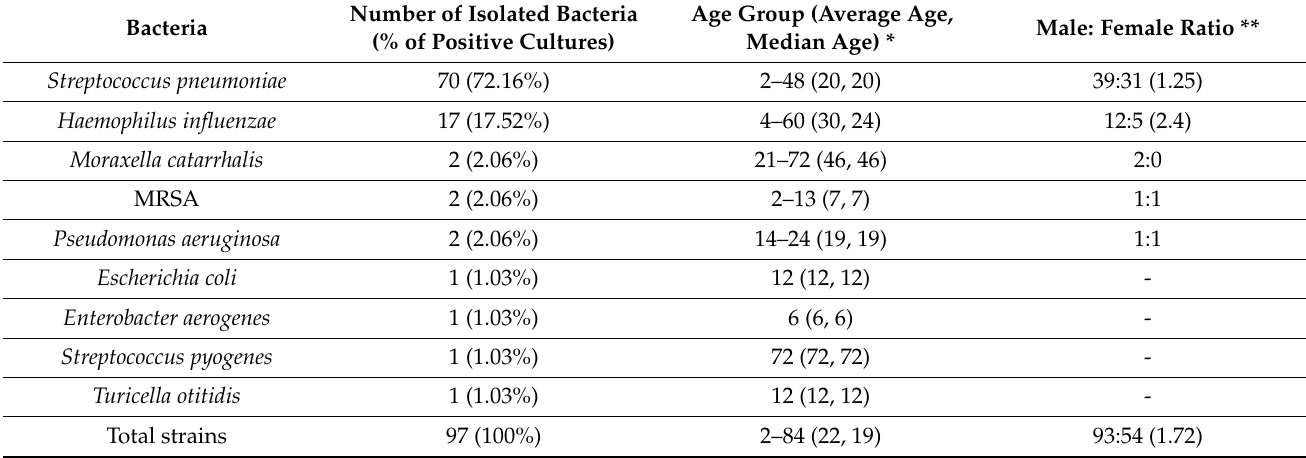
Table 1. Bacteriological flora isolated from the middle ear fluid of children with